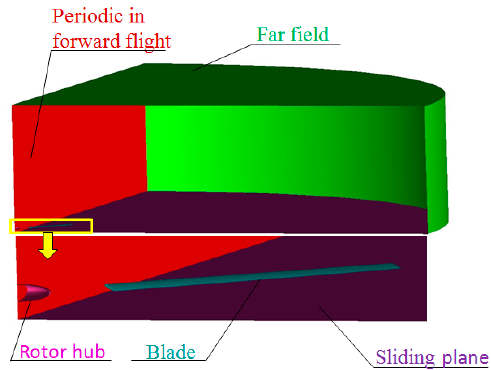
Figure 5. Sliding plane arrangement near the main rotor hub.